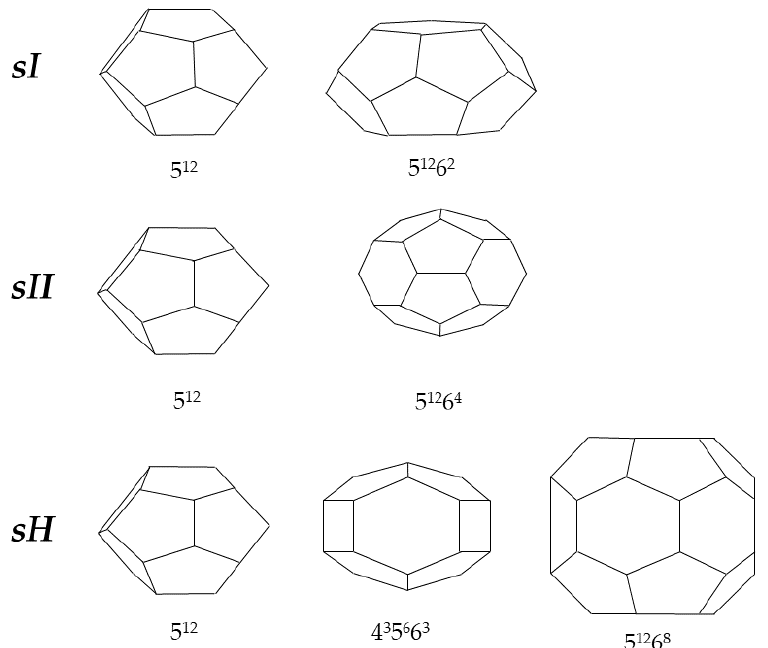
Figure 2. Schematic illustration of the cavities forming the three different hydrate structures.